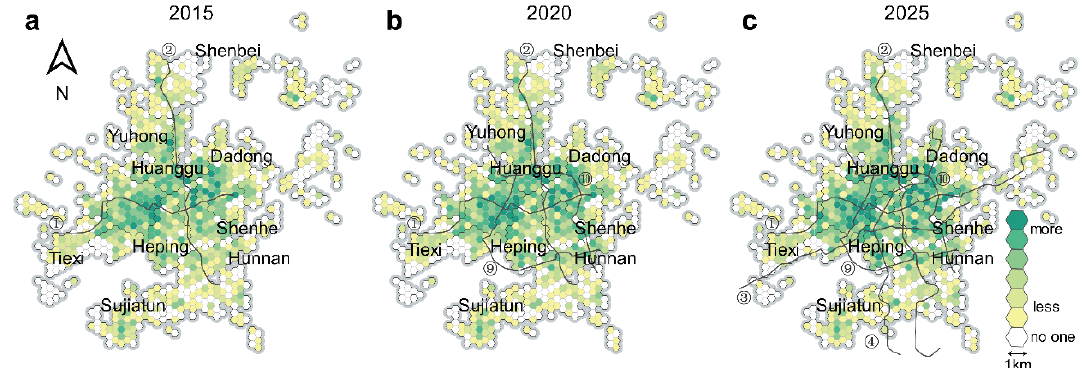
Figure 4. Spatial quantity accessibility to healthcare services at different stages of subway system development: ( a ) accessibility in 2015; ( b ) accessibility in 2020; ( c ) accessibility in 2025.